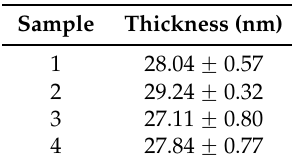
Table 2. Dry thickness of neat poly-[2-(Methacryloyloxy) ethyl] trimethylammonium chloride (PMETAC) brushes measured by ellipsometry at ambient conditions.